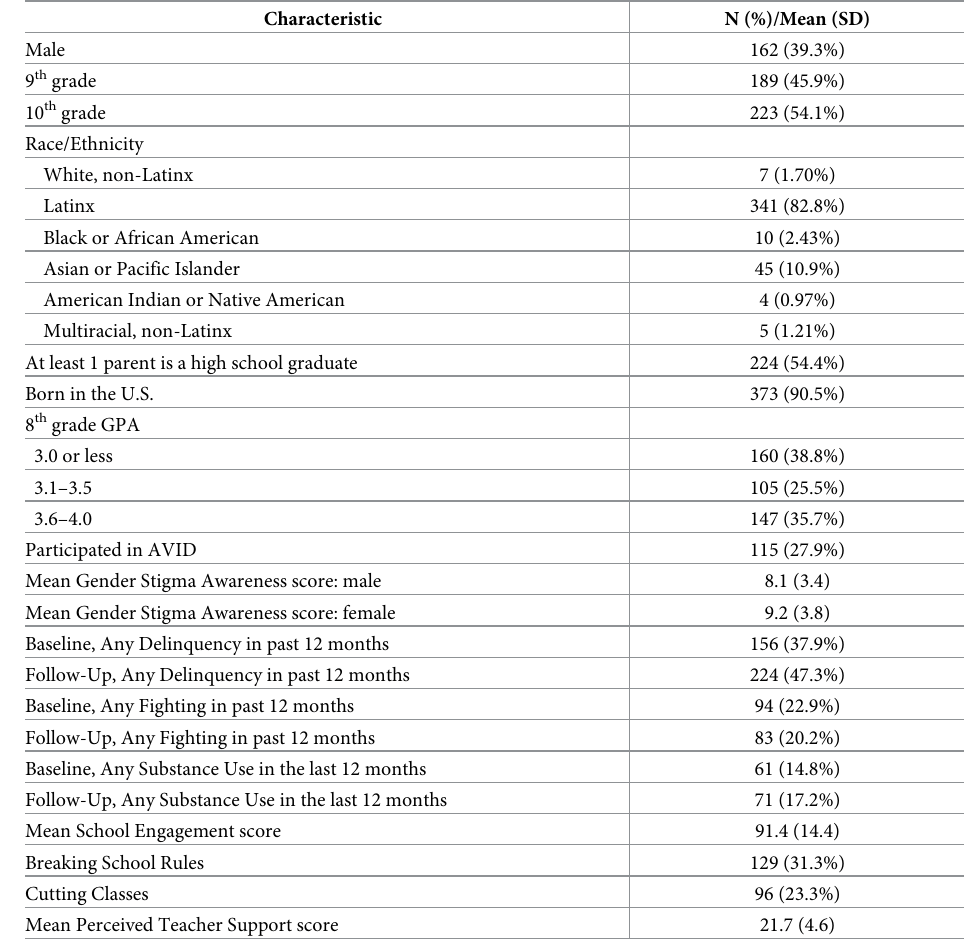
Table 1. Demographics (N =